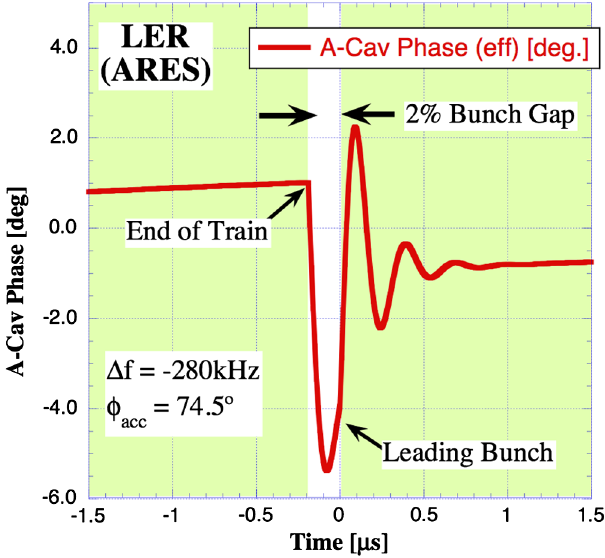
FIG. 8. A plot of the simulated phase modulation shown in Fig. 7, enlarged to show the empty gap